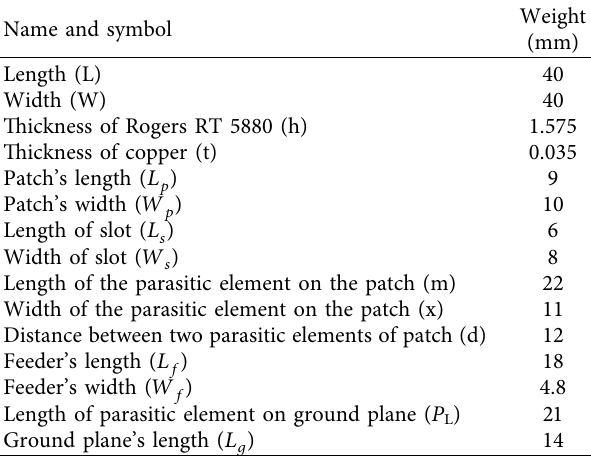
Figure 1: Proposed microstrip patch antenna (MPA). (a) Top view. (b) Back view. (c) 3D view. (d) Fabricated prototype. Table 1: List of the factors of designed